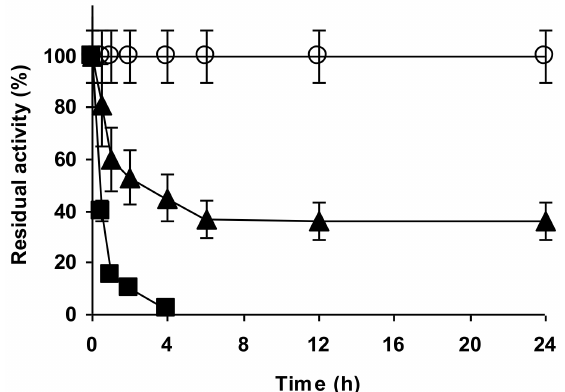
Figure 9. Immobilization of ficin extract on MANAE-agarose beads activated with glutaraldehyde at pH 7 and 200 mM sodium phosphate using BANA as substrate. Experiments were performed as described in Methods, using BANA as substrate. Circles: reference; Triangles: suspension, Squares: